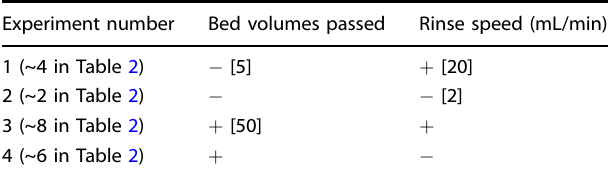
Table 3. 2 2 full-factorial experimental design (experimental set